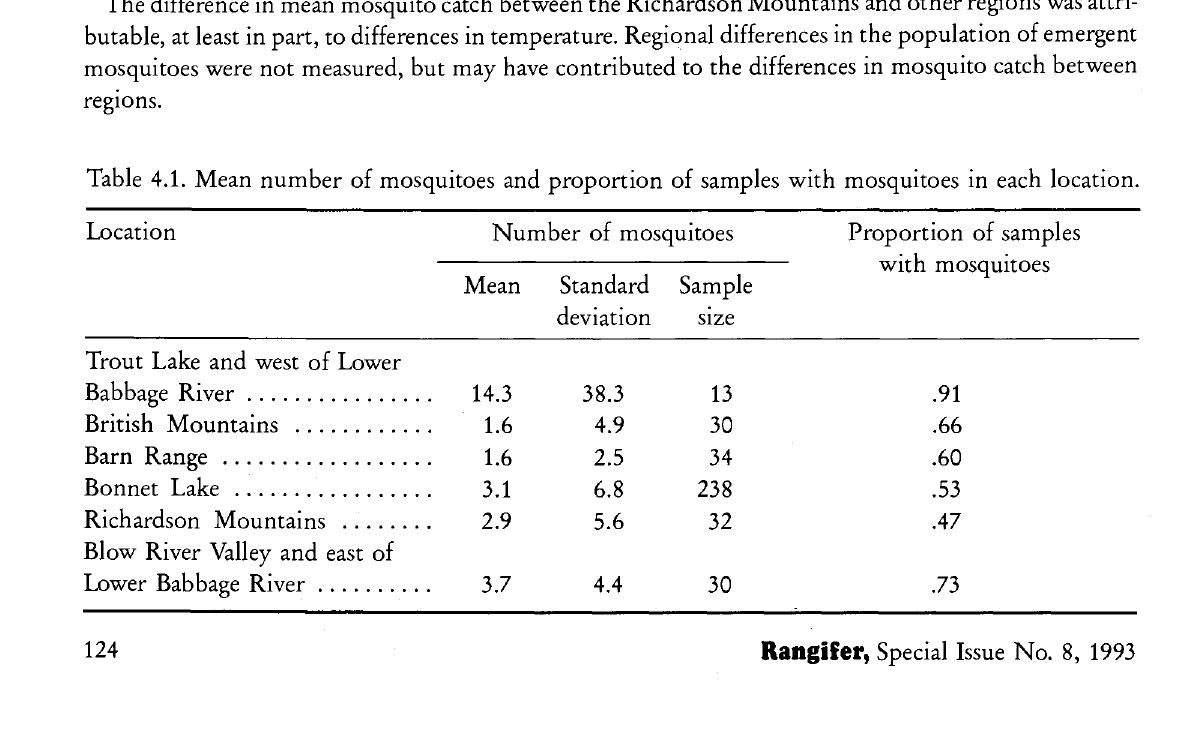
Table 4.1. Mean number of mosquitoes and proportion of samples with mosquitoes in each